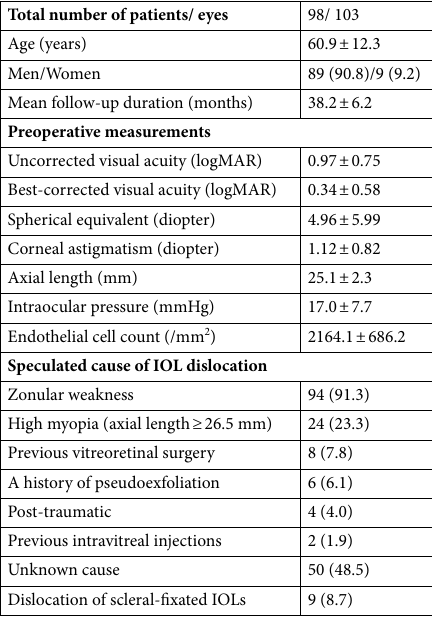
Table 1. Baseline characteristics of the patients who underwent retropupillary iris claw intraocular lens (IOL) implantation surgery with pars plana vitrectomy for the treatment of an IOL dislocation. logMAR, logarithm of the minimum angle of resolution. Values are expressed as means ± standard deviations, except where indicated as number (percentage) of